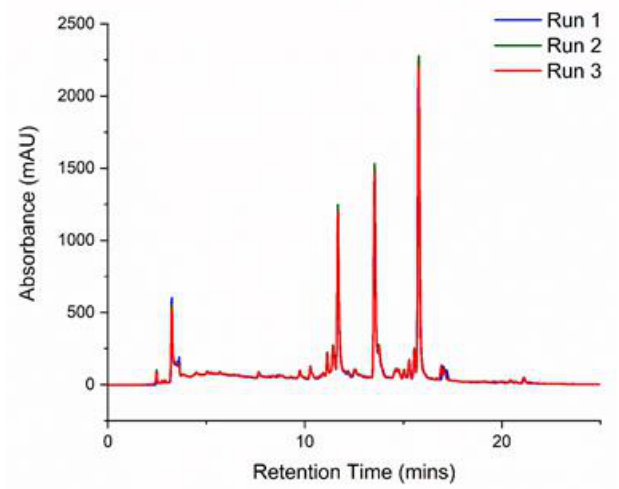
Figure 5. HPLC chromatogram of lemon extract. The extract was run on a C18 column with a mobile phase of water and acetonitrile; repeated thrice.